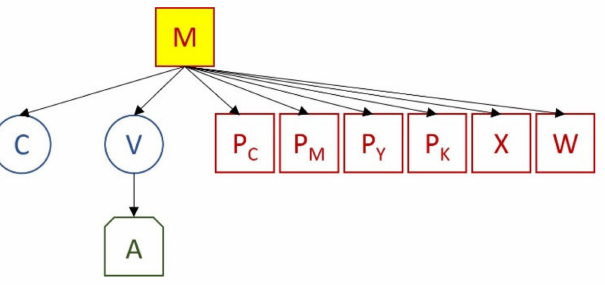
Figure 3. Task decomposition diagram for the paint-mixing robot agent showing the Mix Paint task (highlighted) and its component task